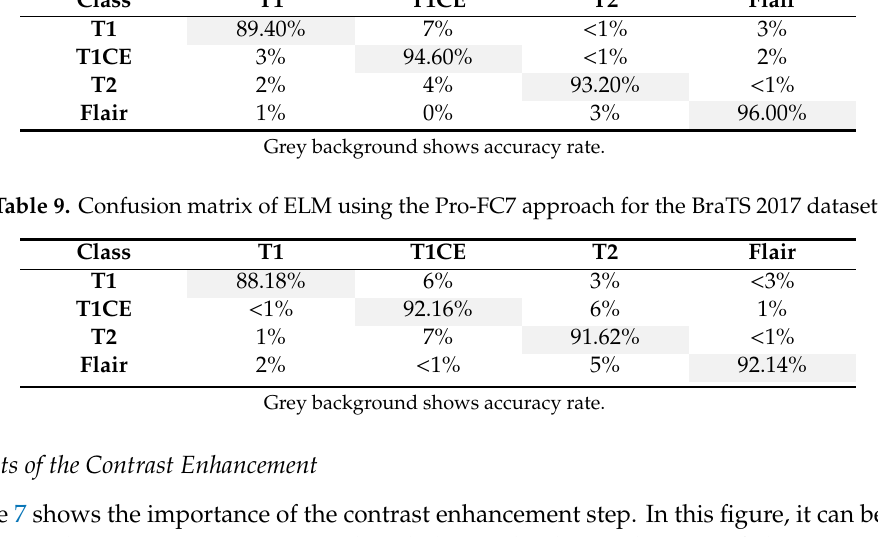
Table 10. Detailed statistical analysis of the proposed method using the BraTS 2015 dataset. Method